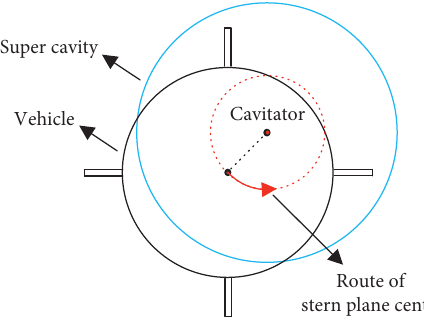
Figure 4: Auto-oscillation of SVs (back view).